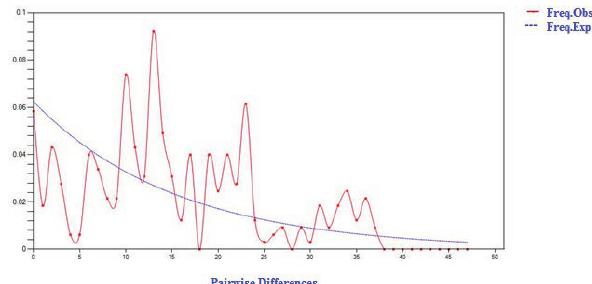
Figure 5. Pair-wise mismatch plot of trnHG-psbA sequences in Avi- cennia species.